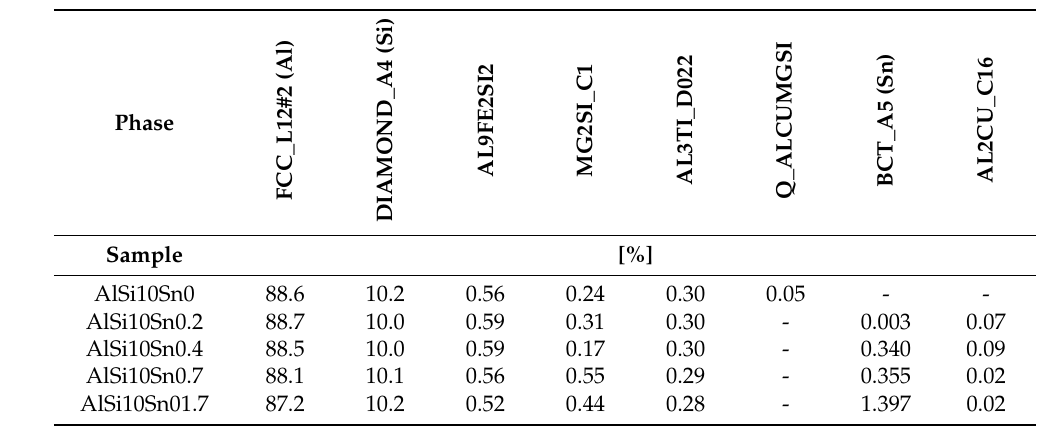
Table 5. Results of modelling of alloys (mass fraction at 20 ◦ C (%)).